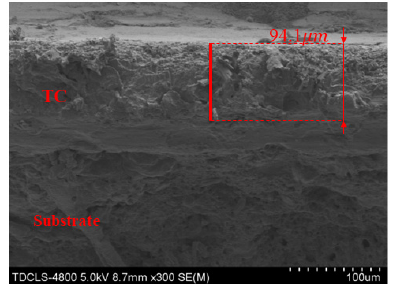
Figure 5. The TBC result of the SEM.